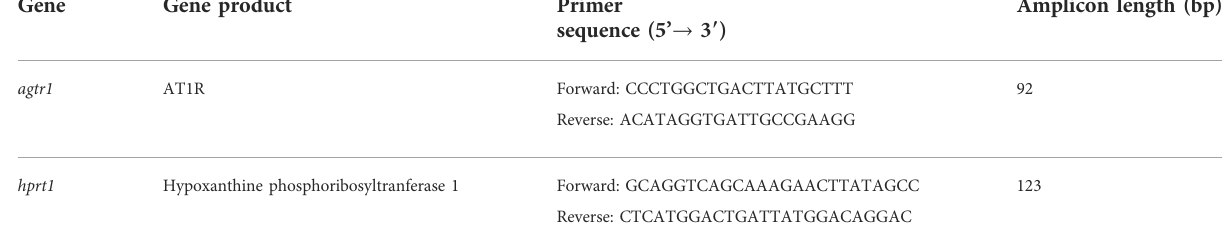
media and images taken at 40x magni fi cation. The level of